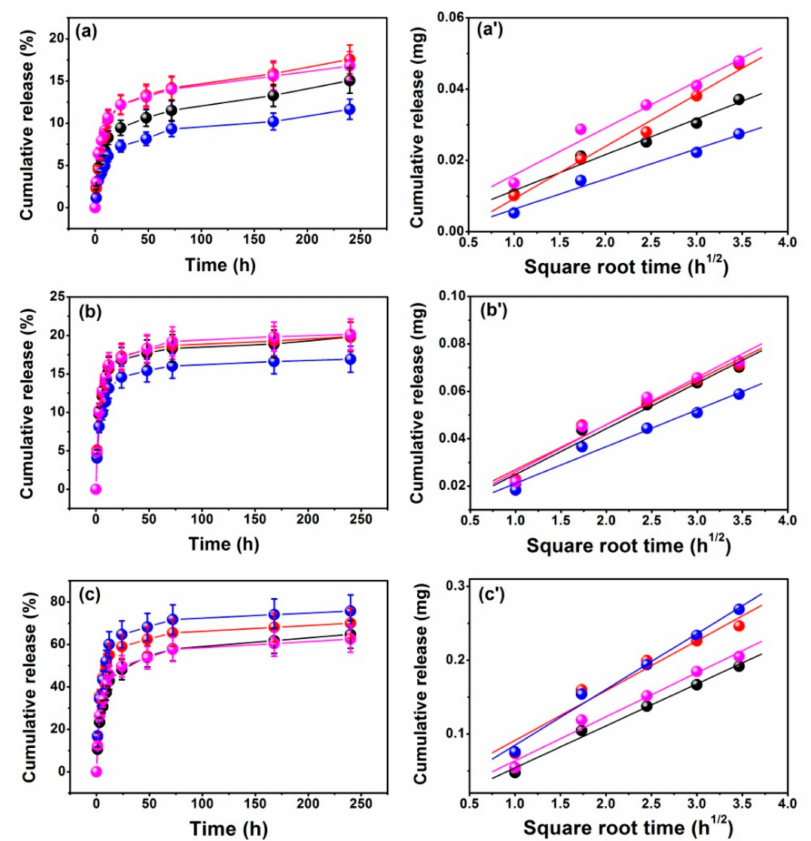
Figure 5. Cumulative release of doxorubicin (DOX) from Eu/MBGs in PBS with different pH values ( a – c ) and fitted to the first 12 h of data by the Higuchi model ( a’ – c’ ). ( a , a’ ) DOX release at pH 8.6, ( b , b’ ) DOX release at pH 7.4, ( c , c’ ) DOX release at pH 4.3; black “ ” symbols 0 Eu/MBGs; red “ ” symbols 0.5 Eu/MBGs; blue “ ” symbols 1 Eu/MBGs; magenta “ ” symbols 2